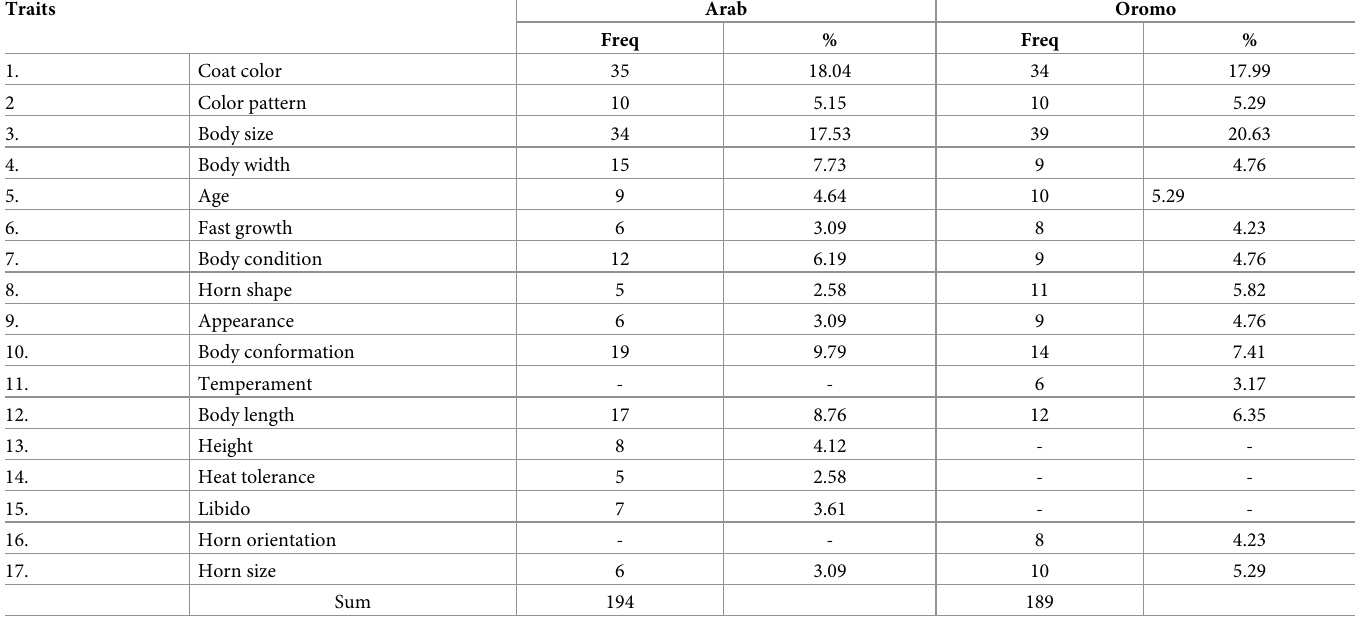
Table 4. List of buck traits in group-animal ranking